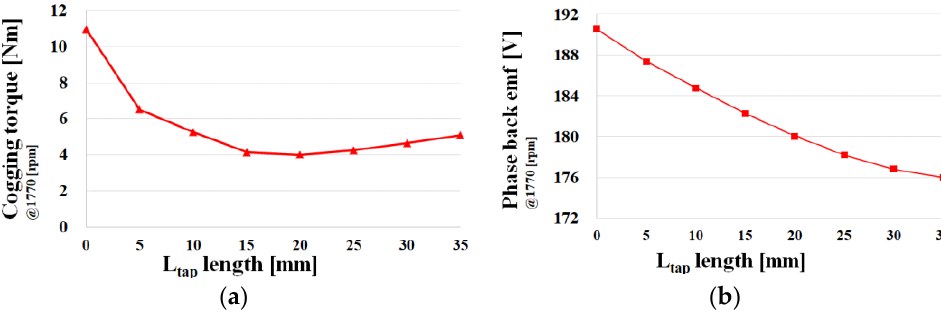
Figure 6. Cogging torque and back emf according to the length of L tap : ( a ) cogging torque; ( b ) back emf.